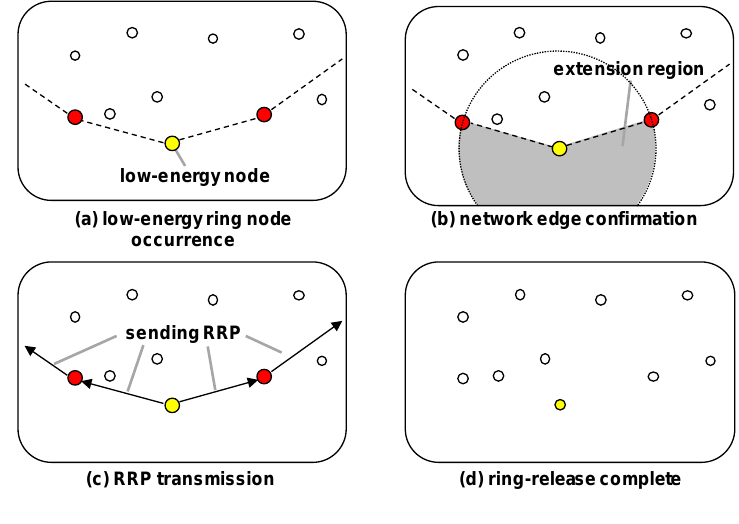
Figure 6. Release of ring in the MRR